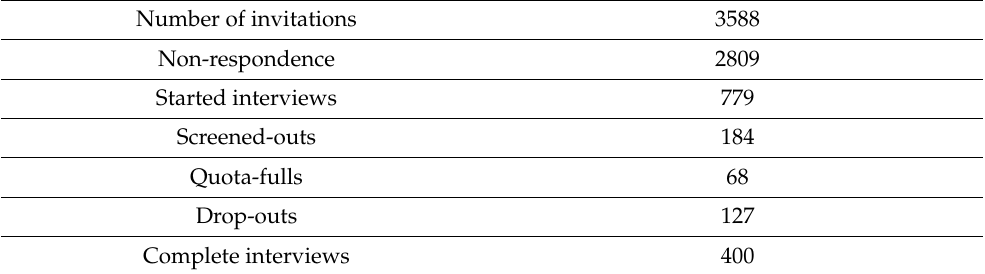
Table 3. Survey fieldwork report, Latvia, May